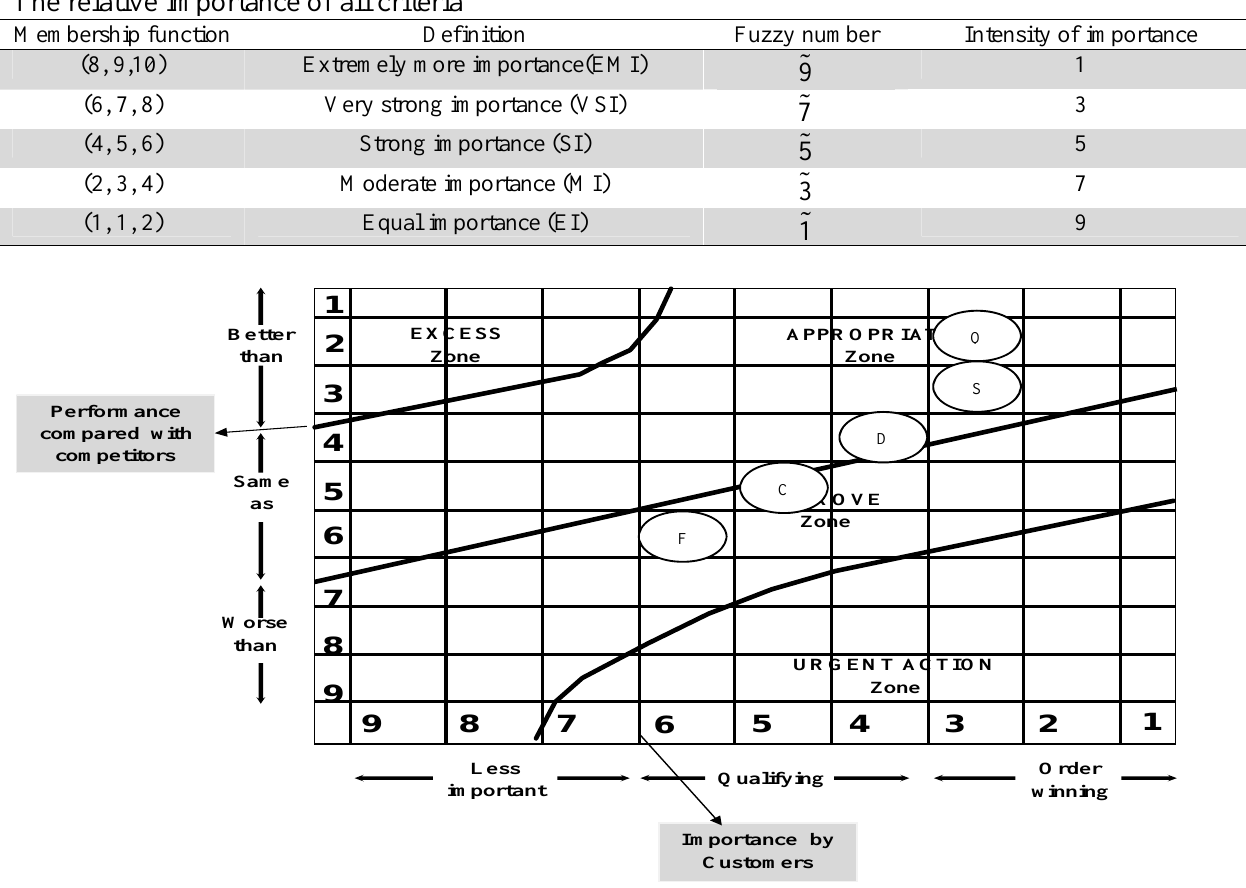
Fig. 4. The Importance-Performance Matrix of firm C